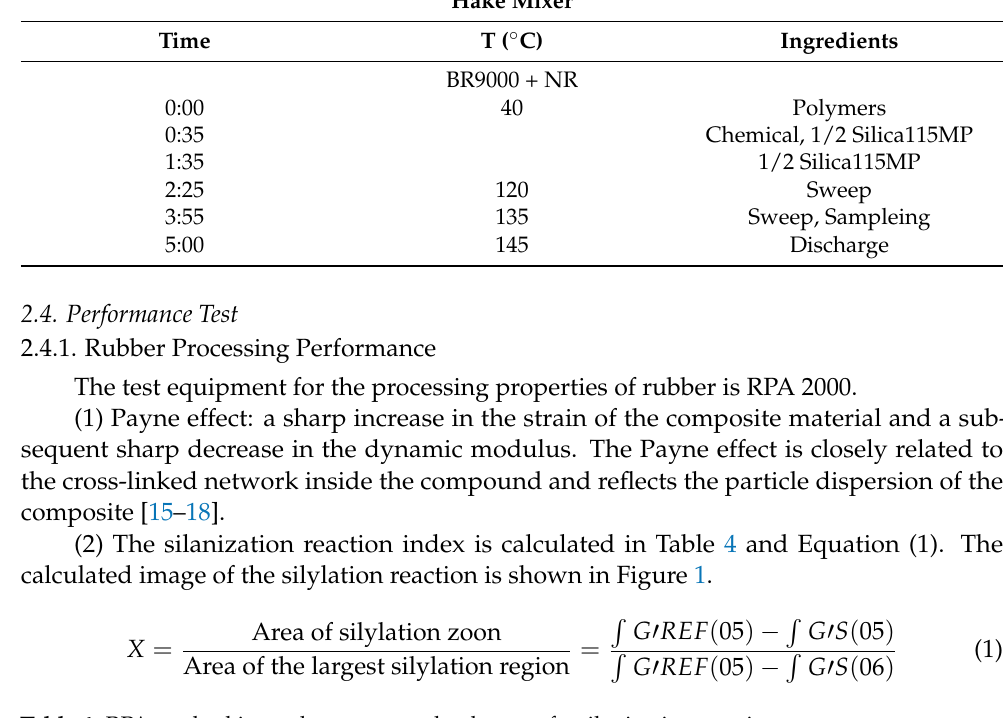
Table 4. RPA method is used to measure the degree of a silanization reaction.